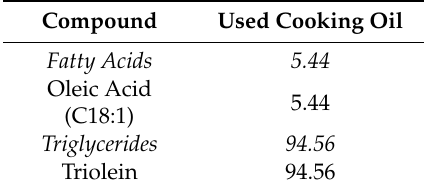
Table A1. GC-MS analysis of the used cooking oil used in the catalytic upgrading experiments. Text in italics corresponds to compound classes comprising the individual compounds listed. Values shown are